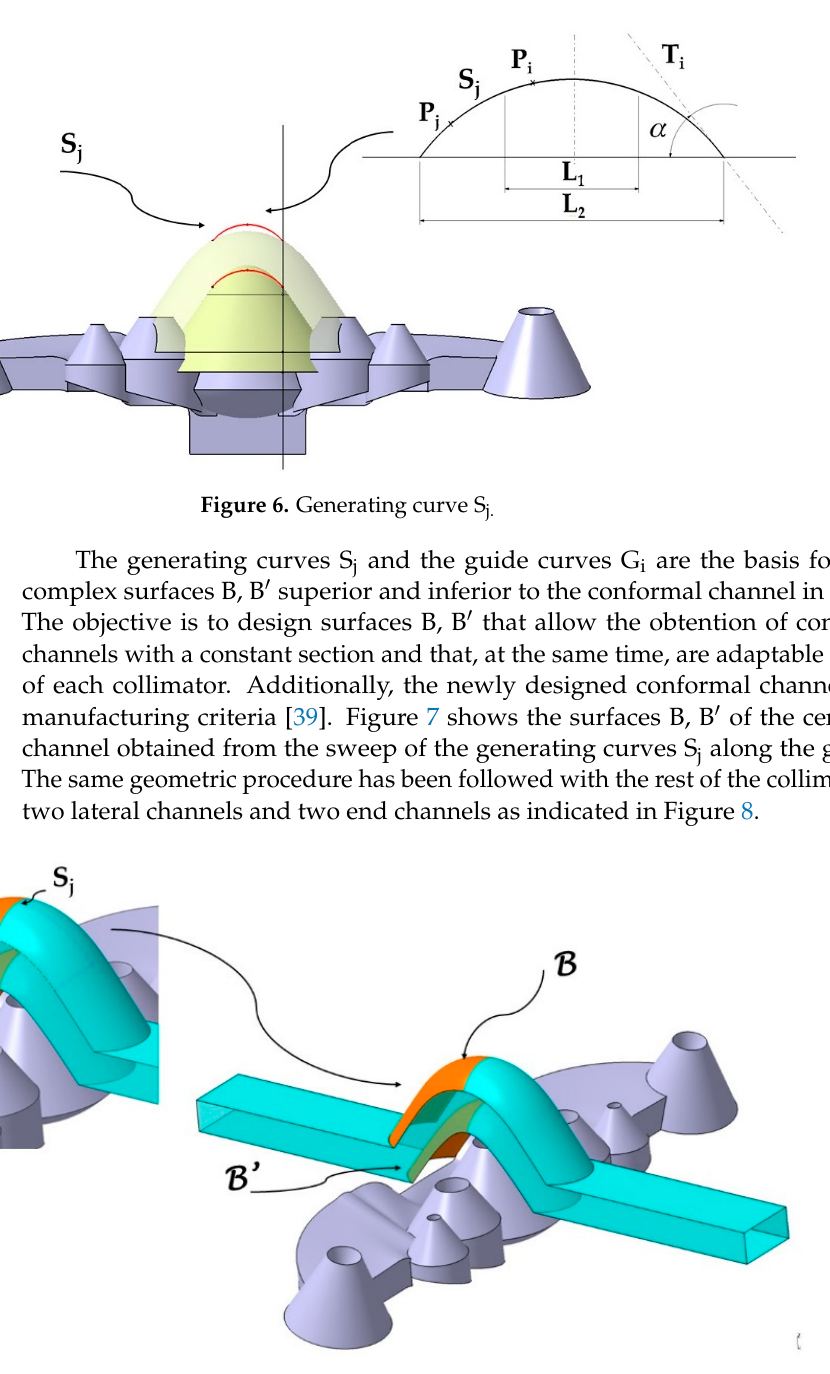
Figure 7. End surfaces B, B’ of the central conformal channel obtained from the sweep of the generating curves S j along the guide curves G i .